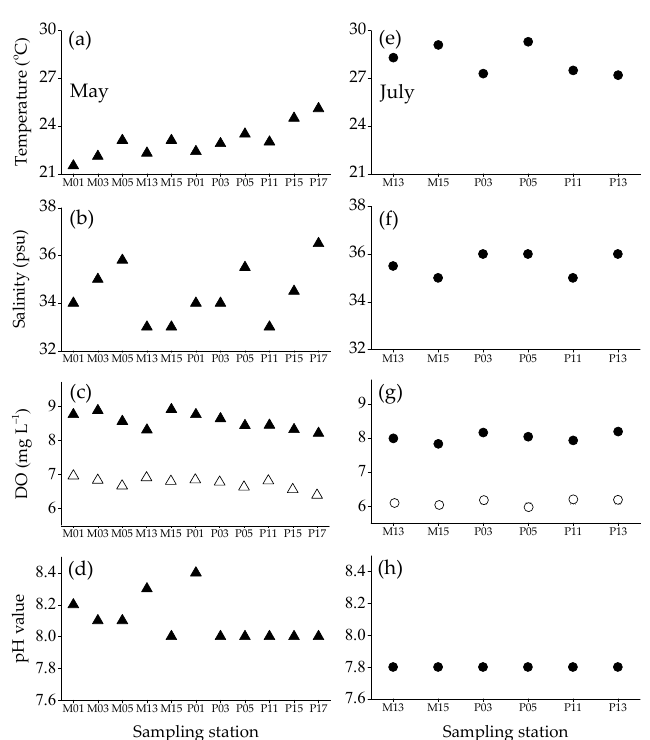
Figure 2. Temperature ( a , e ), salinity ( b , f ), dissolved oxygen (DO) concentration ( c , g ), and pH value ( d , h ) in the surface water of the Taiwan Strait during the cruises in May (left) and July (right) 2019. Salid and hollow points in panels ( c , g ) represent the measured and saturated DO concentrations, respectively.